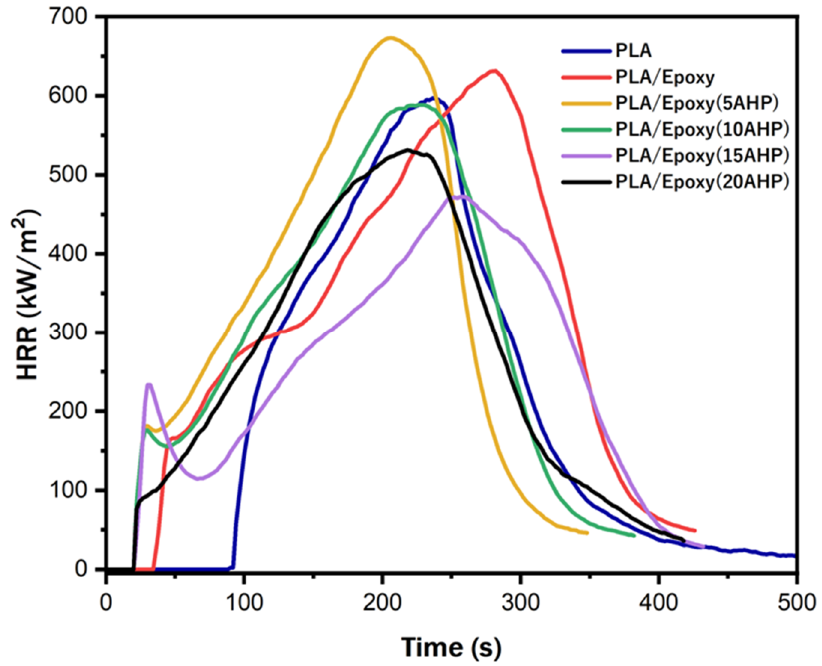
Figure 8. Heat release rate (HRR) obtained in MLC test of PLA (sheets) coated with epoxy–AHP nanocomposites compared to PLA/blank epoxy resin and pristine PLA.